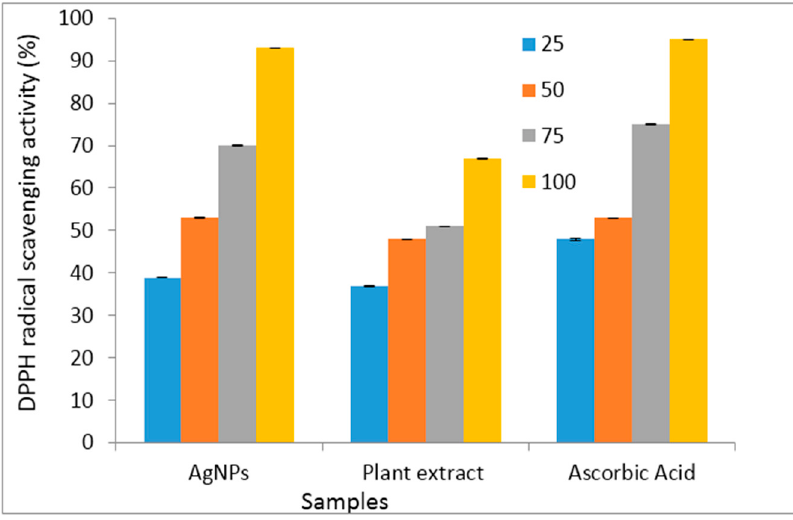
Figure 10. Histogram presentation of DPPH radical scavenging results.